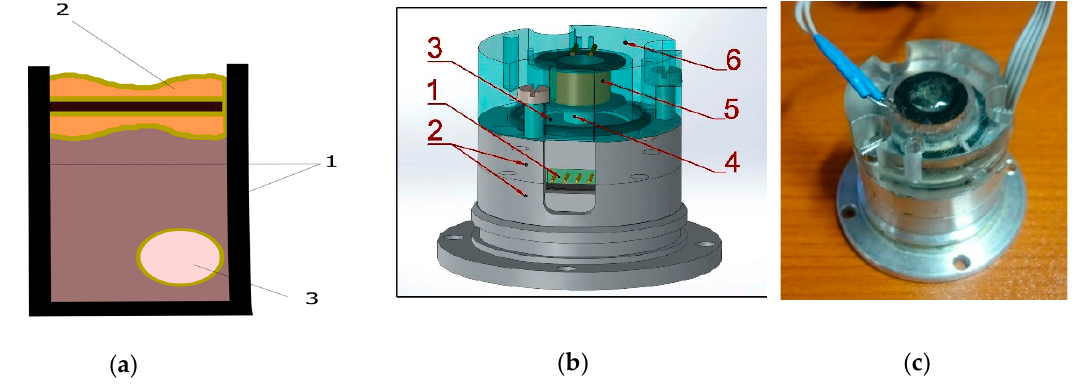
Figure 1. Hydrophone: ( a ) scheme; ( b ) design [19]; ( c ) experimental sample [19].